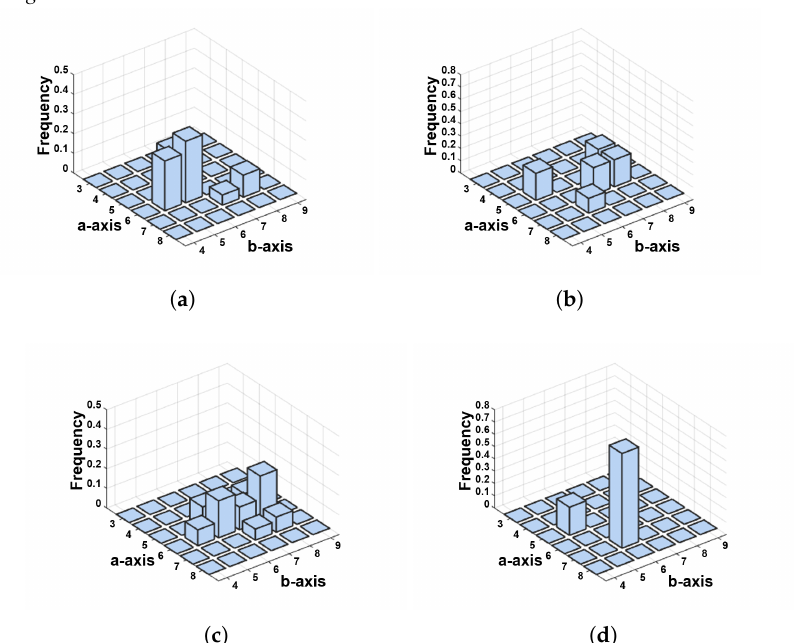
Figure 4. Apparent and absent color histograms. ( a ) H P for image 1. ( b ) H N for image 1. ( c ) G P for image 2. ( d ) G N for image